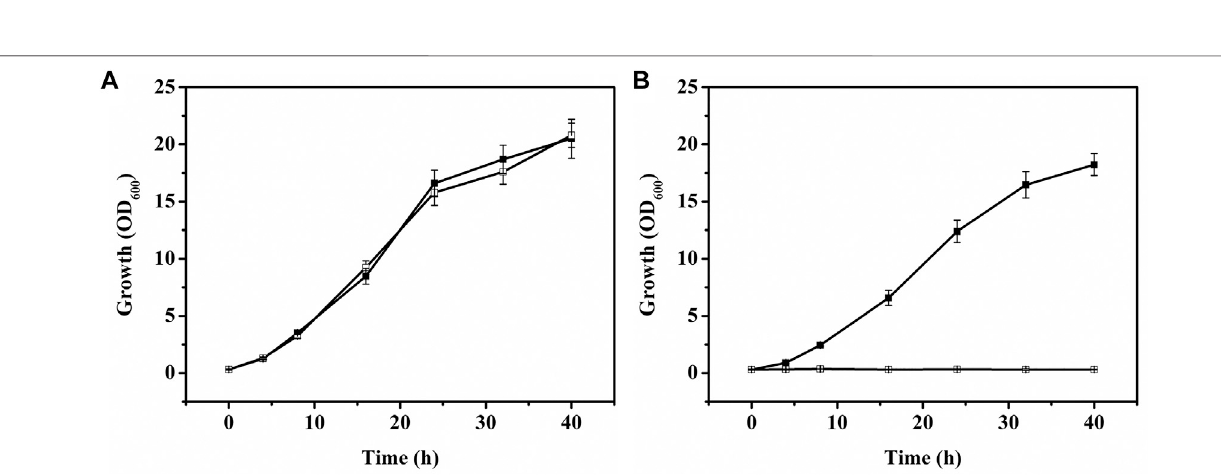
FIGURE 6 | Growth of C. glutamicum strains on glucose or myo-inositol. (A) Growth of C. glutamicum ATCC 13032 [ fi lled square ( ■ )] and C. glutamicum Δ iolG Δ oxiC Δ oxiD Δ oxiE [whitesquare( □ )]onglucose. (B) Growthof C.glutamicum ATCC13032[ fi lledsquare( ■ )]and C.glutamicum Δ iolG Δ oxiC Δ oxiD Δ oxiE [white square ( □ )] on